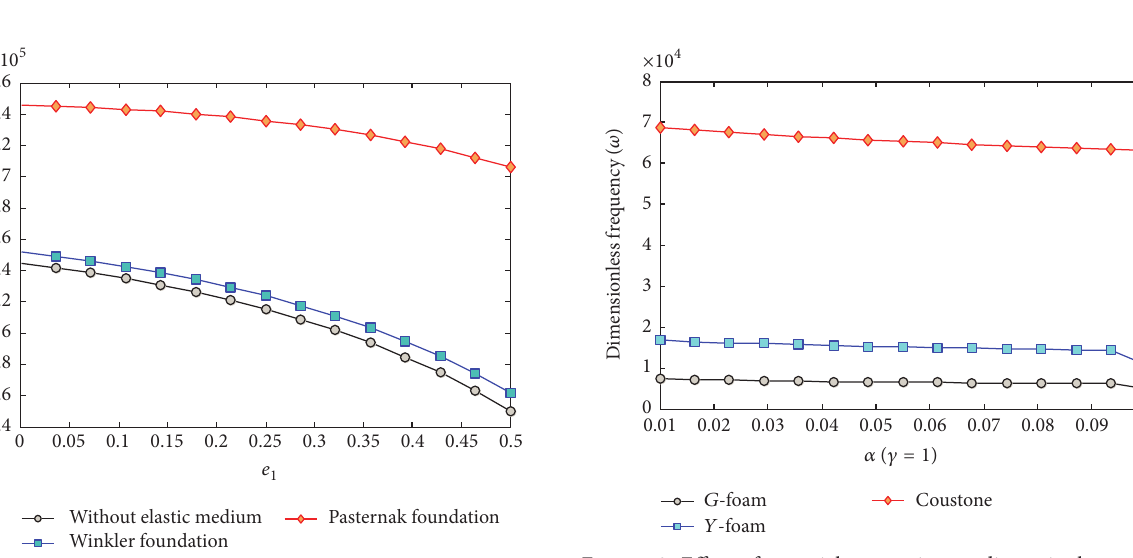
Figure 7: Effect of elastic medium on dimensionless natural frequency.